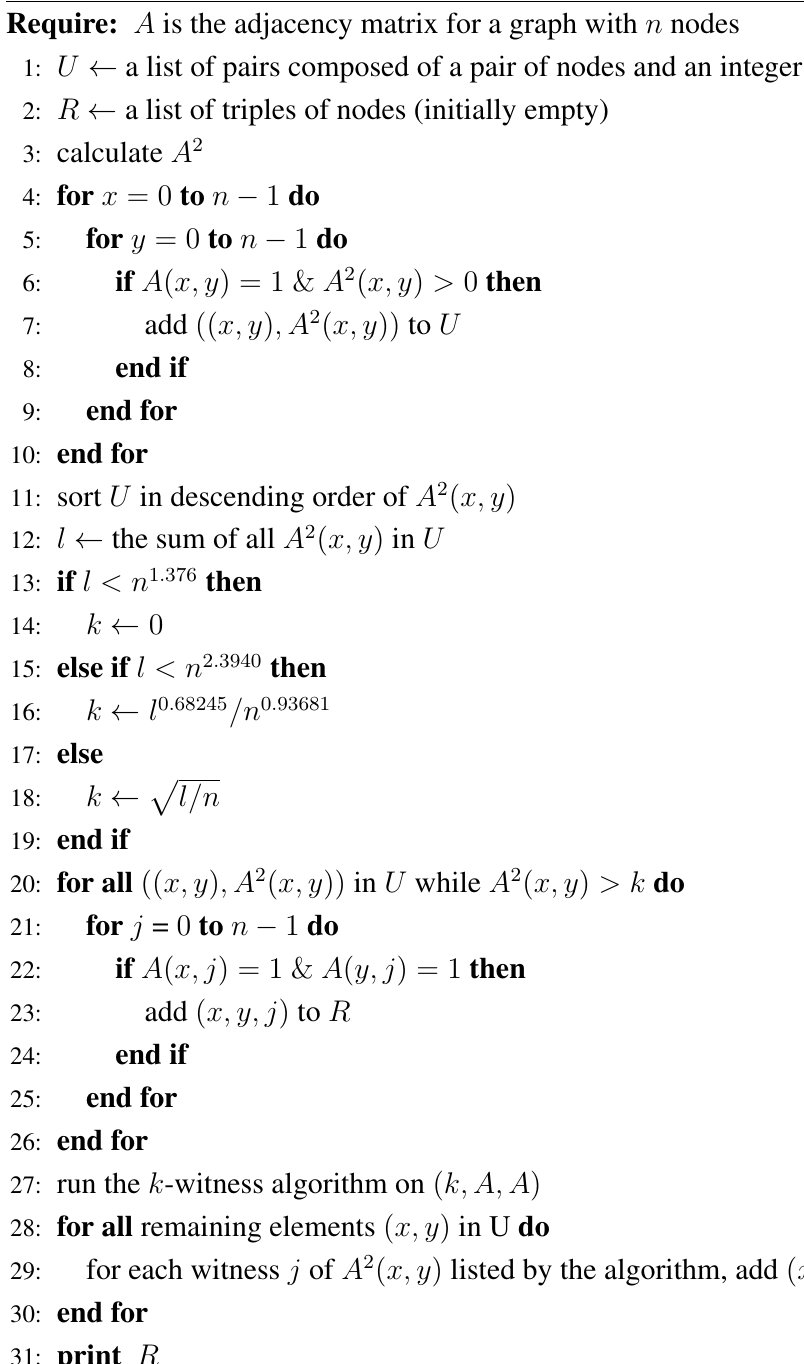
Algorithm 1 A combined algorithm for listing of